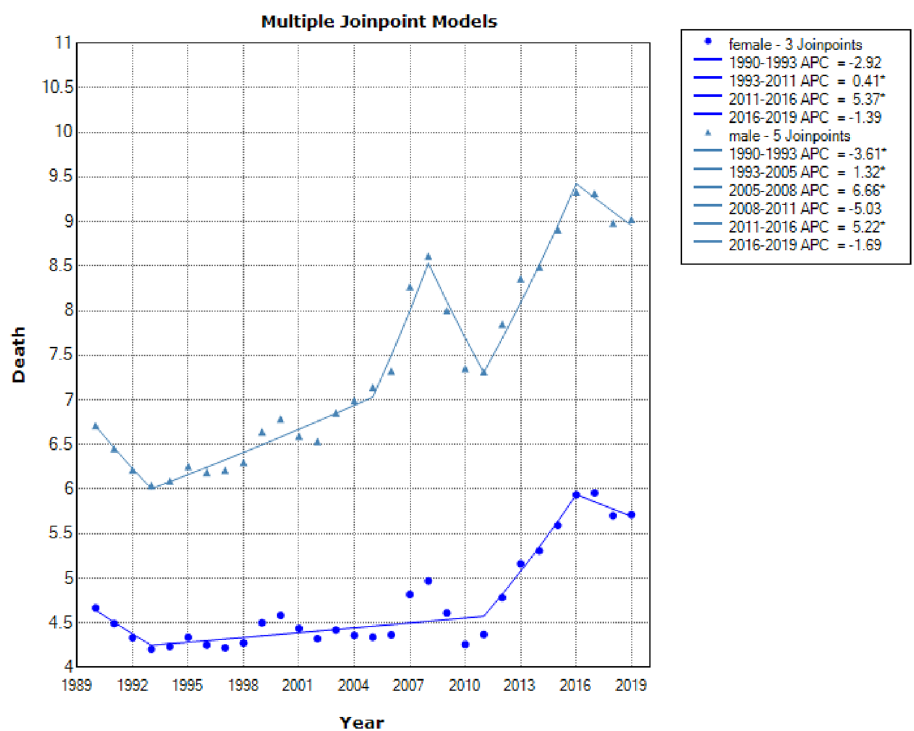
Figure 7. Joinpoint regression model for death due to ambient ozone exposure in aged +50 by gender: